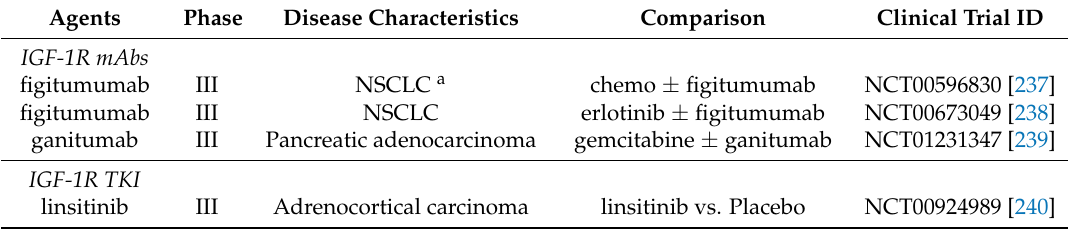
Table 7. Published phase III studies of IGF1R